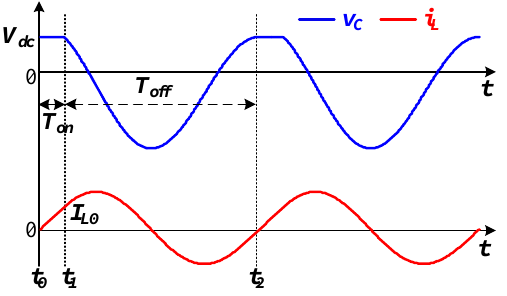
Figure 3. Voltage and current waveforms in critical ZVS conditions.